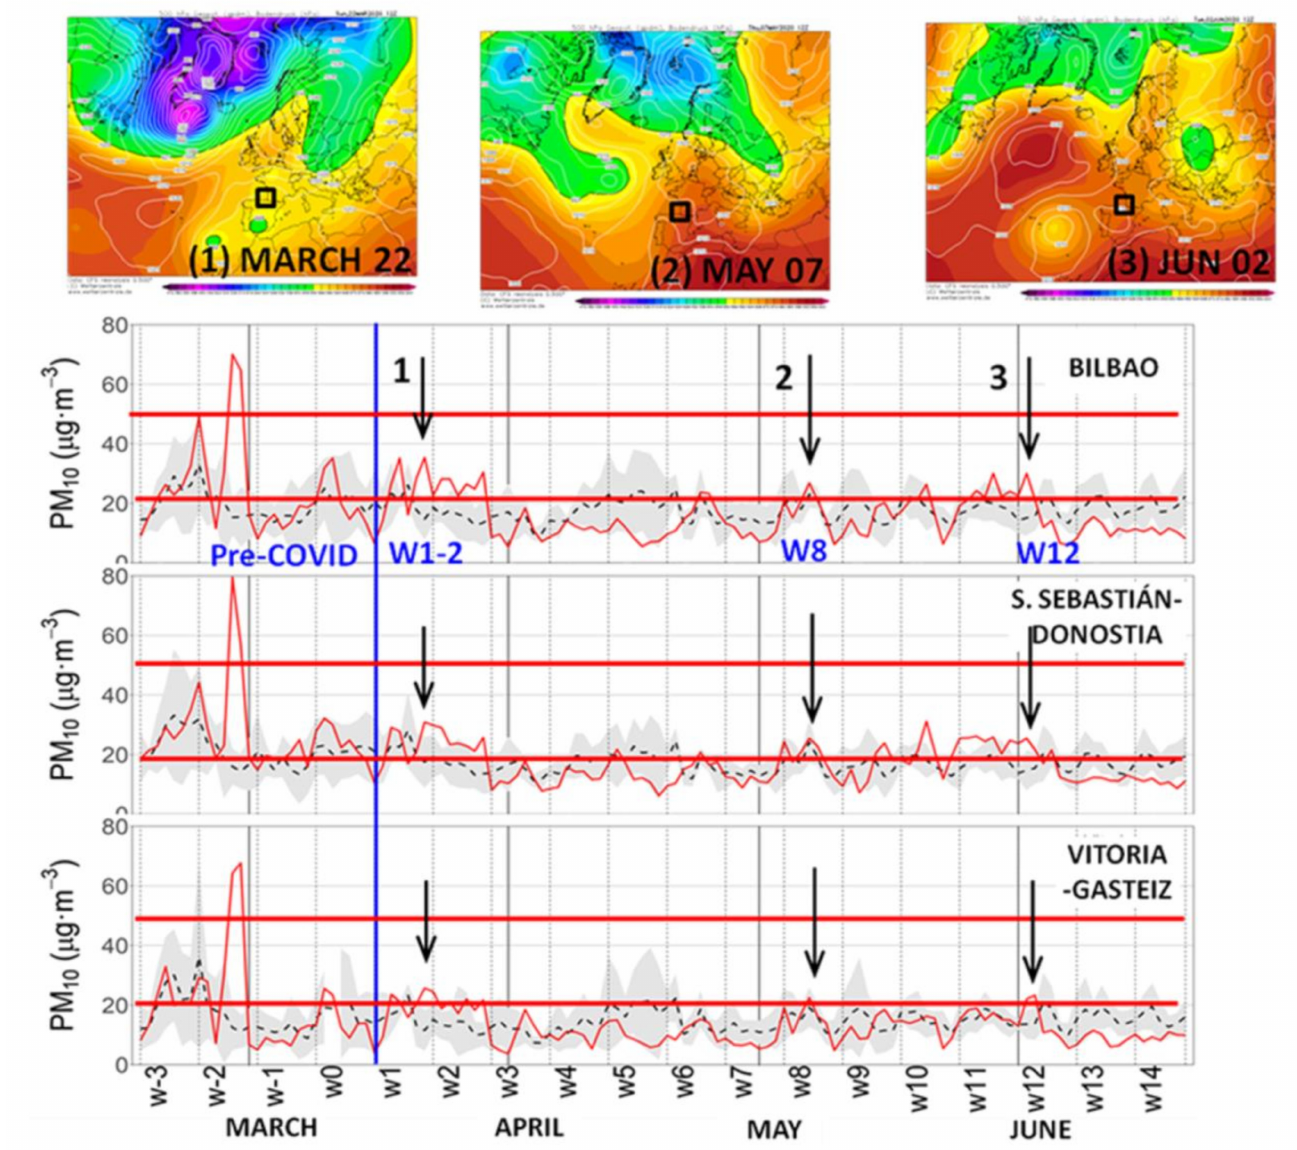
Figure 8. 24-h average concentration series of PM 10 at the three main urban sites. As in Figure 7 , inter-annual values (dashed lines) with their standard deviation (gray shading), and the lockdown daily values (solid red) are represented. Three PM 10 episodes, above the reference level of the WHOAQG of 20 µ g · m − 3 , for the annual average concentration (horizontal red line), are marked (arrows) during weeks 1–2, 8, and 12 of the lockdown period. The respective synoptic forcings are shown (upper panels) in the Climate Forecast System Reanalysis (CFSR), one panel per episode, as in Figure